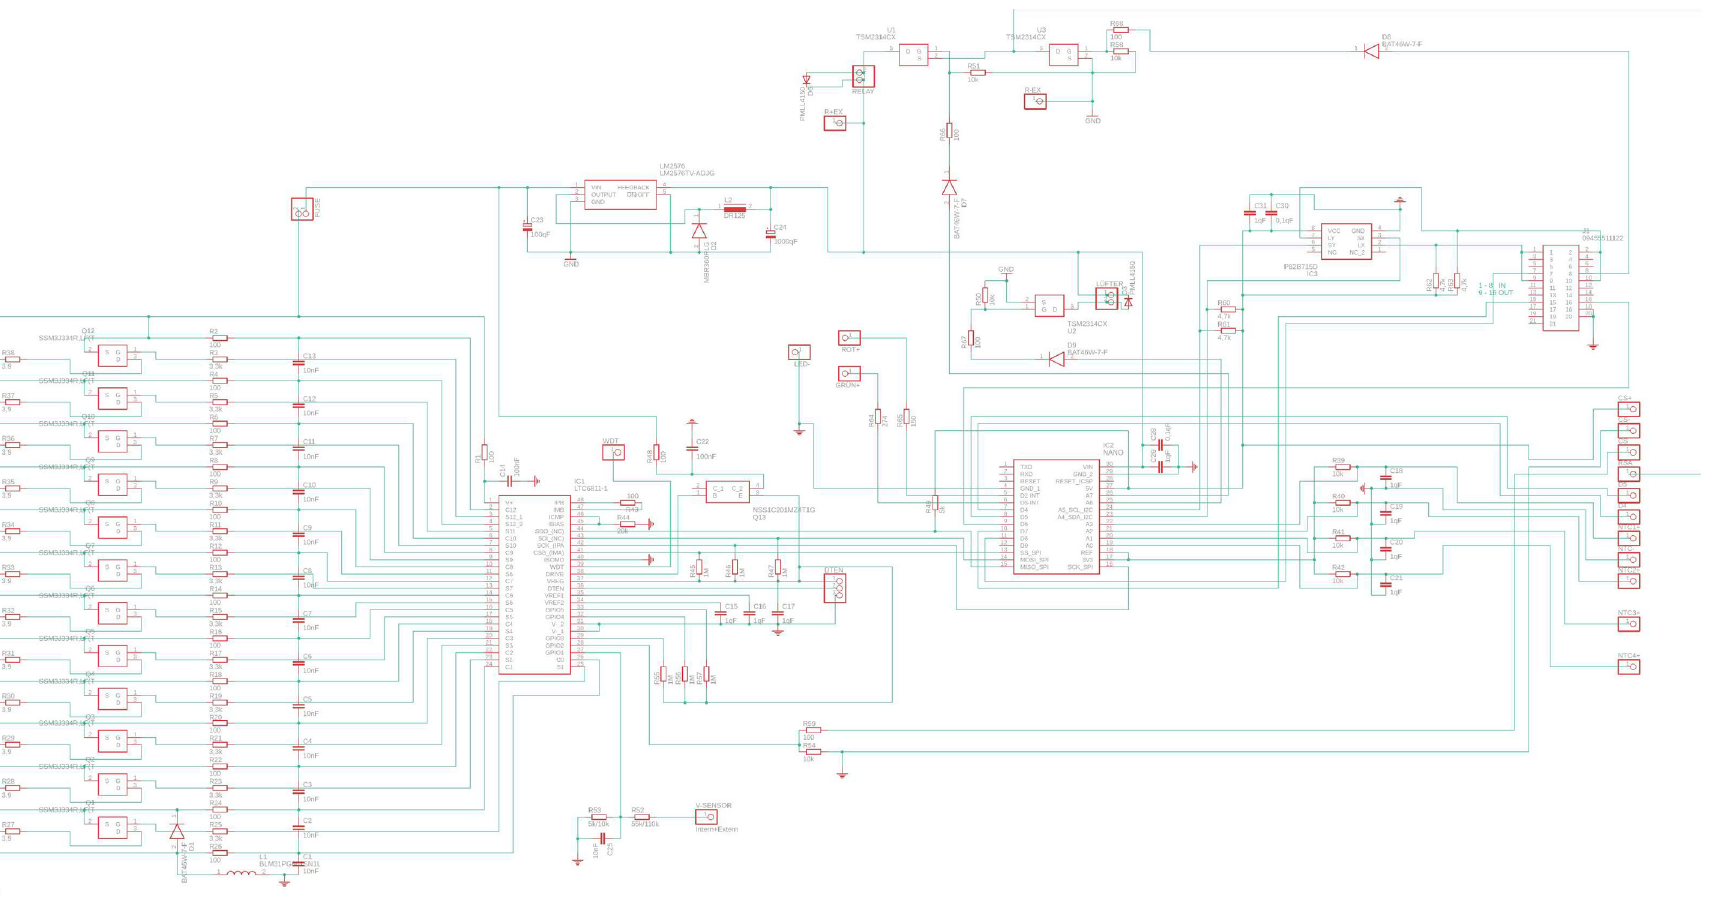
Figure A2. Electrical circuit diagram of the battery management system developed within the framework of this project.